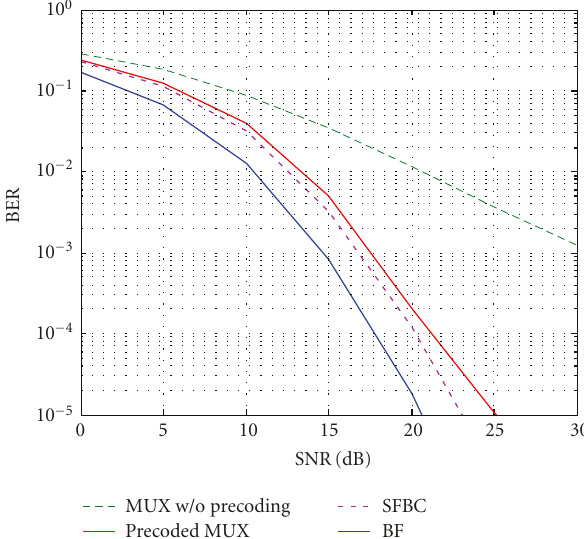
Figure 9: Average BER for di ff erent MIMO-OFDM techniques with a fixed spectral e ffi ciency of 4bits/s/Hz and low spatial correlation ( v = 3km/h, ρ = 0 .